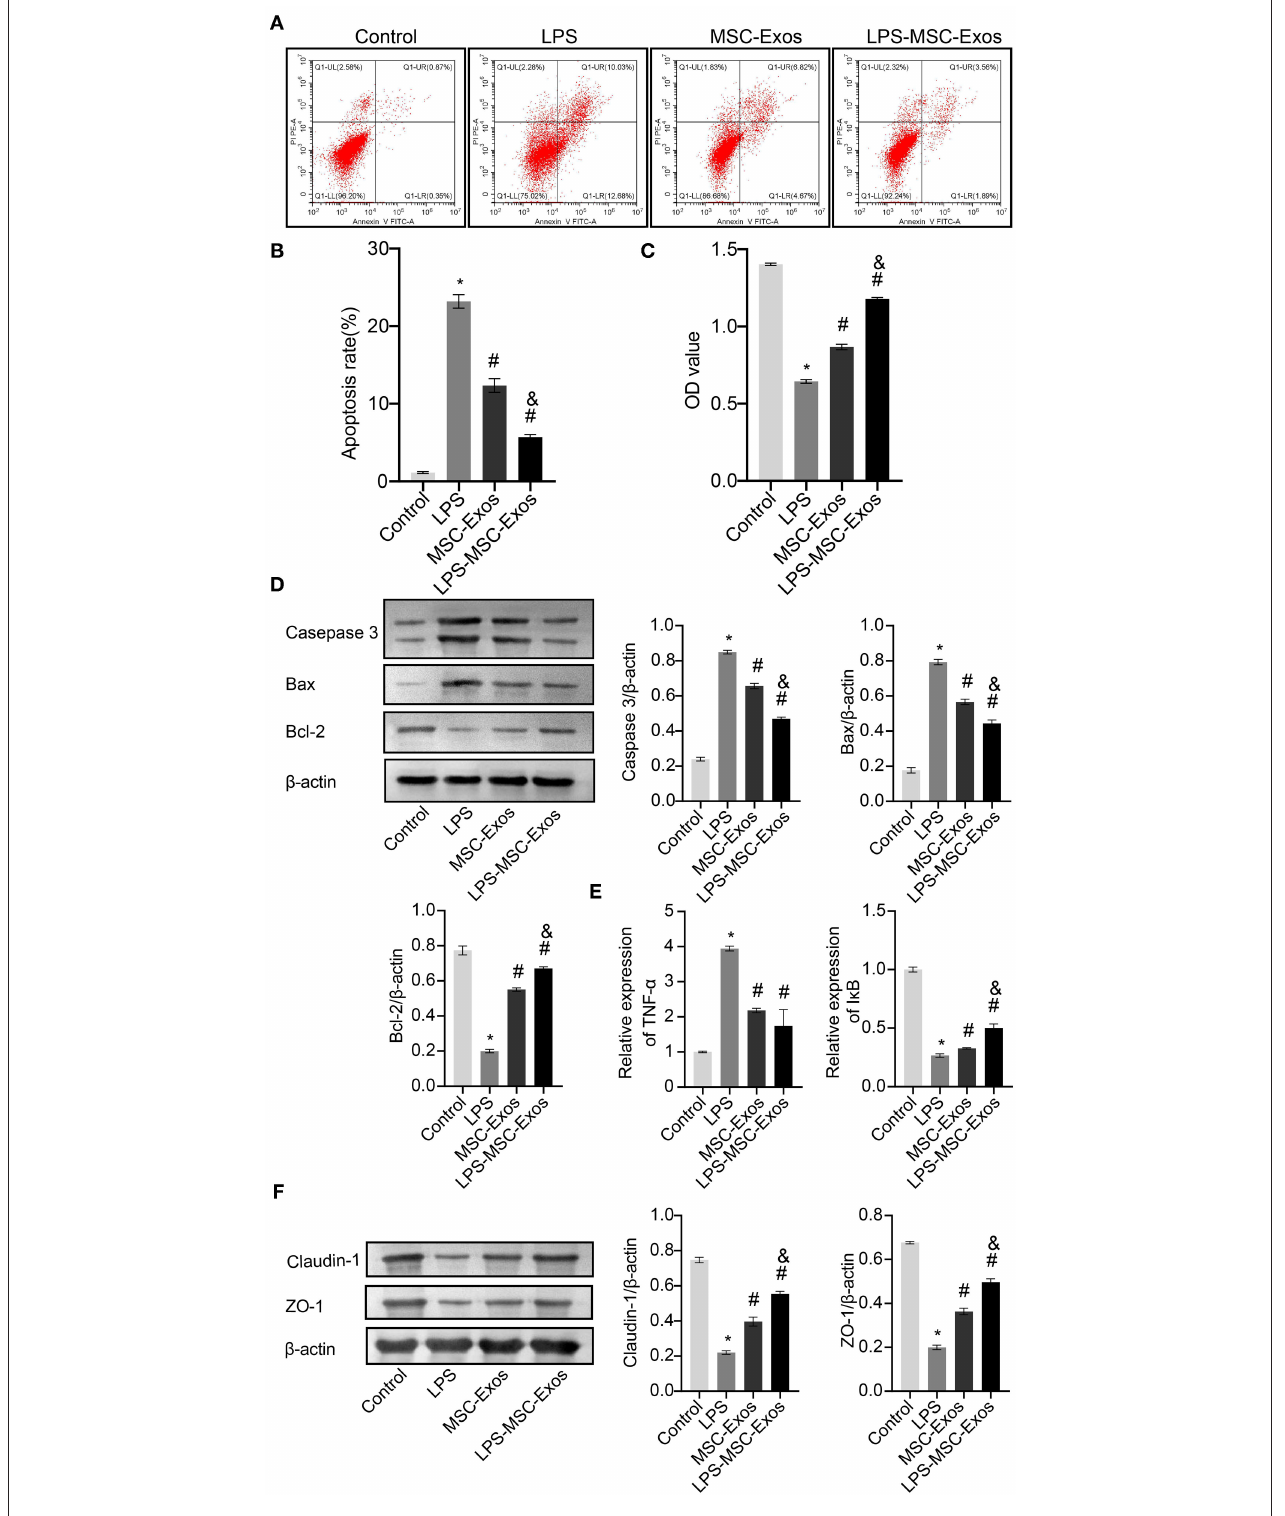
FIGURE 2 | MSC-Exos and LPS-MSC-Exos prevented LPS-induced injury in vitro . (A,B) Apoptosis was detected by flow cytometry. (C) CCK-8 assays were used to detect the viability of HCOEPICs. (D) Western blotting was performed to detect the expression of Caspase-3, Bax, and Bcl-2 in HCOEPICs. (E) qRT-PCR was used to detect the expression levels of TNF- α and I κ B in HCOEPICs. (F) The expression levels of Claudin-1 and ZO-1 were detected via Western blotting. * P < 0.05 vs. the control. # P < 0.05 vs. the LPS group. & P < 0.05 vs. the MSC-Exo group. MSC, mesenchymal stem cell; Exos, exosomes; LPS, lipopolysaccharide; DSS, dextran sodium sulfate; CCK-8, Cell Counting Kit 8; HCOEPICs, human colonic epithelial cells.